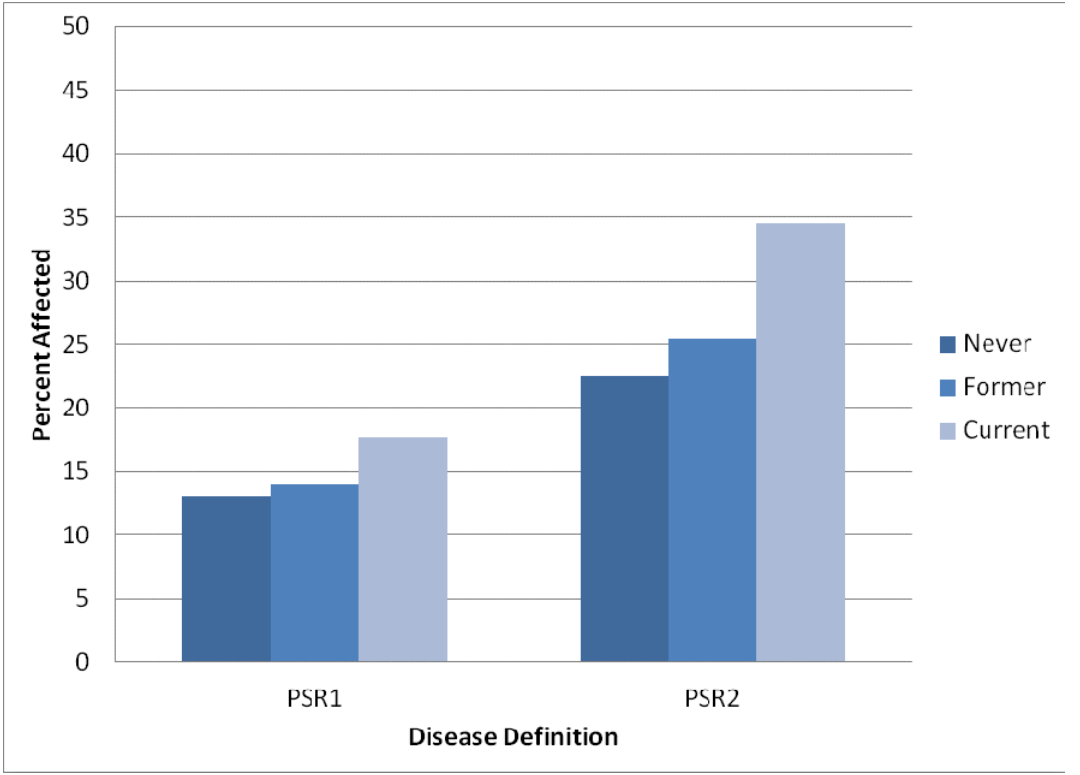
Figure 1. Relationship of smoking status with PSR1 and